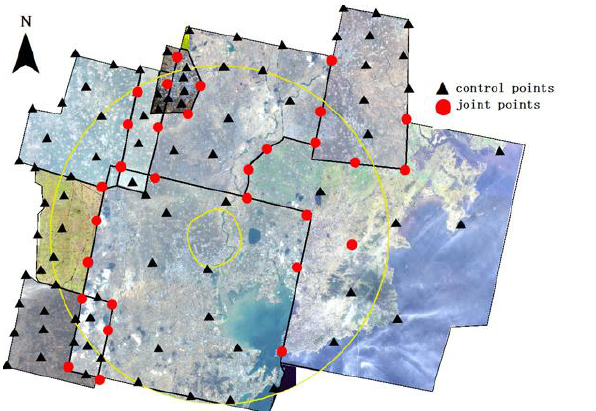
Figure 4. ZY-3 Scenes and control